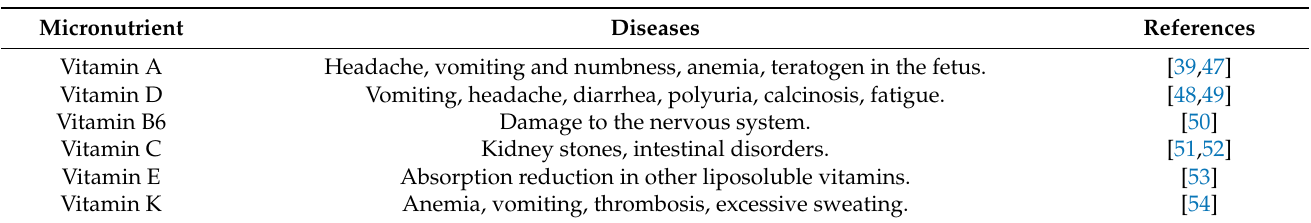
Table 3. Hypervitaminosis effects in